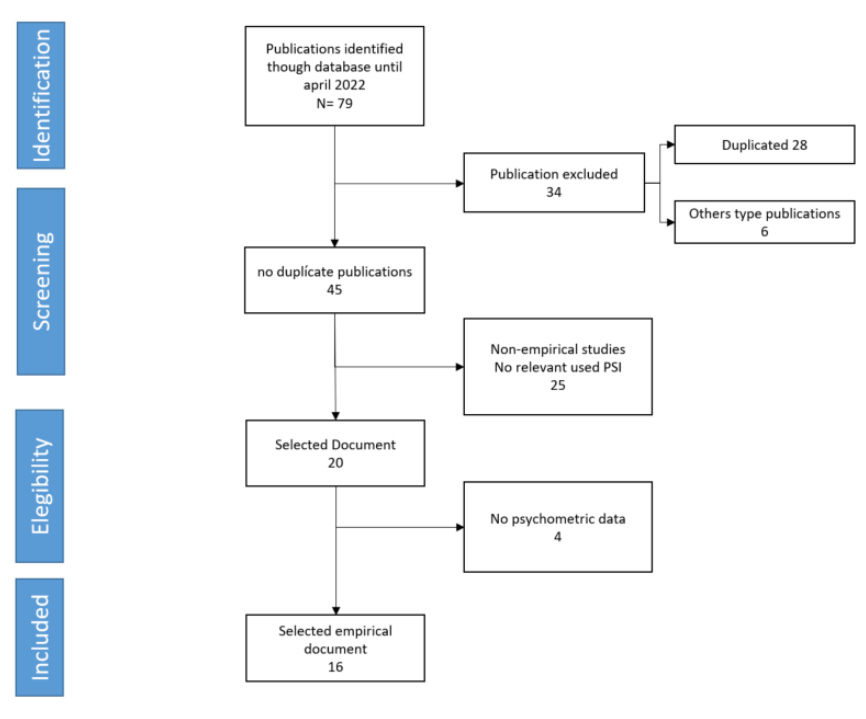
Figure 1. PRISMA flow diagram displaying article selection process.